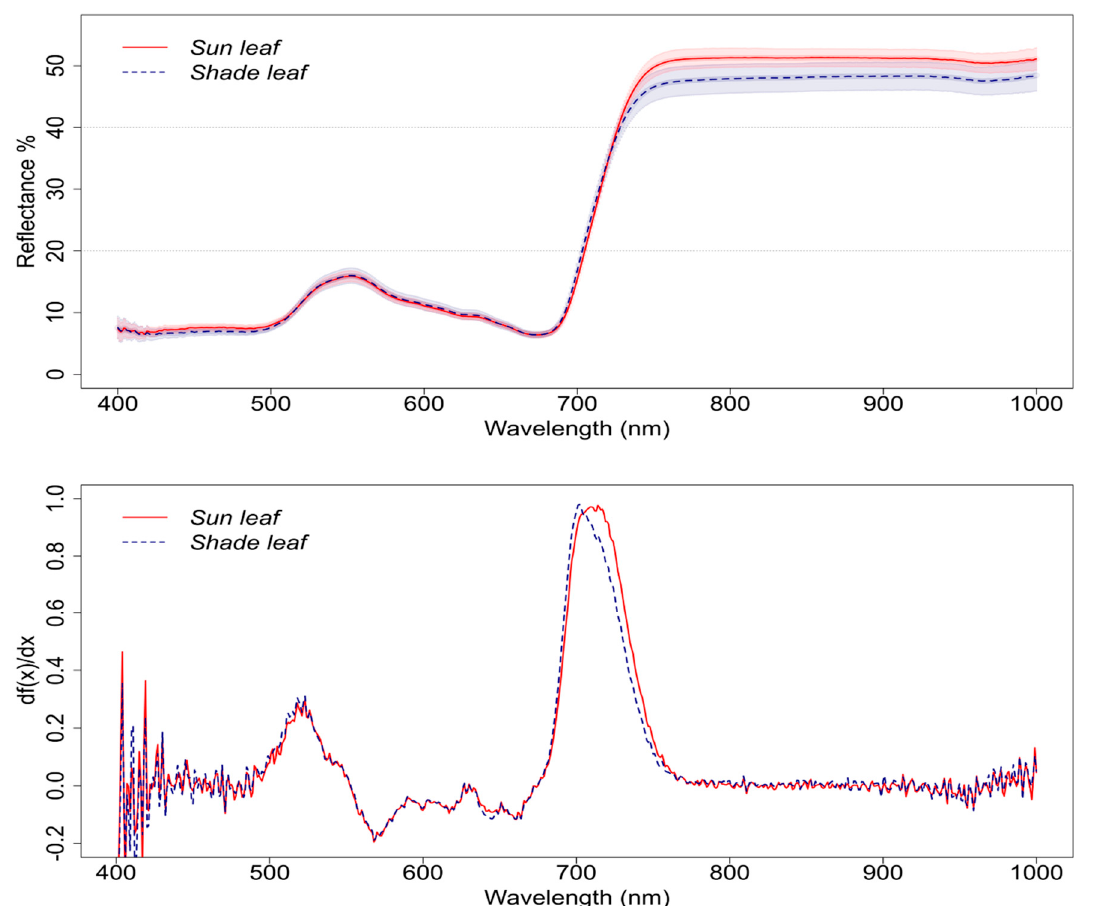
Figure 5. Mean (curve) and standard deviation (shaded area) of relative reflectance ( ρ ) of Phragmites australis sun (solid line) and shade (dashed line) leaves (upper inset) and the first derivative (lower inset). Each line is an average of 12 measurements.